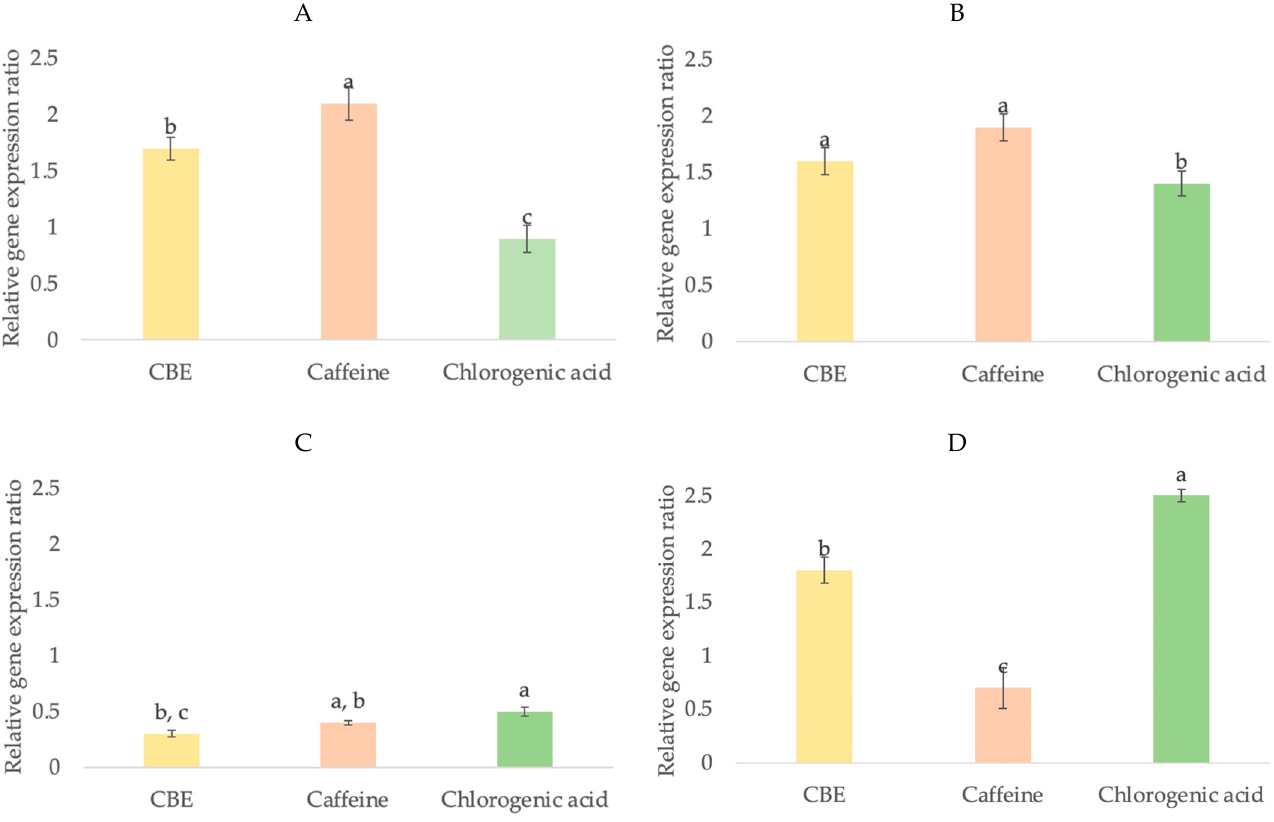
Figure 8. Relative fold expression levels of IGF-1 ( A ), KGF ( B ), HGF ( C ) and VEGF ( D ) genes in HFDP cells. Values are presented as means ± SD ( n = 3). Data with different lower-case letters (a, b and c) indicate significant differences ( p < 0.05) between samples.